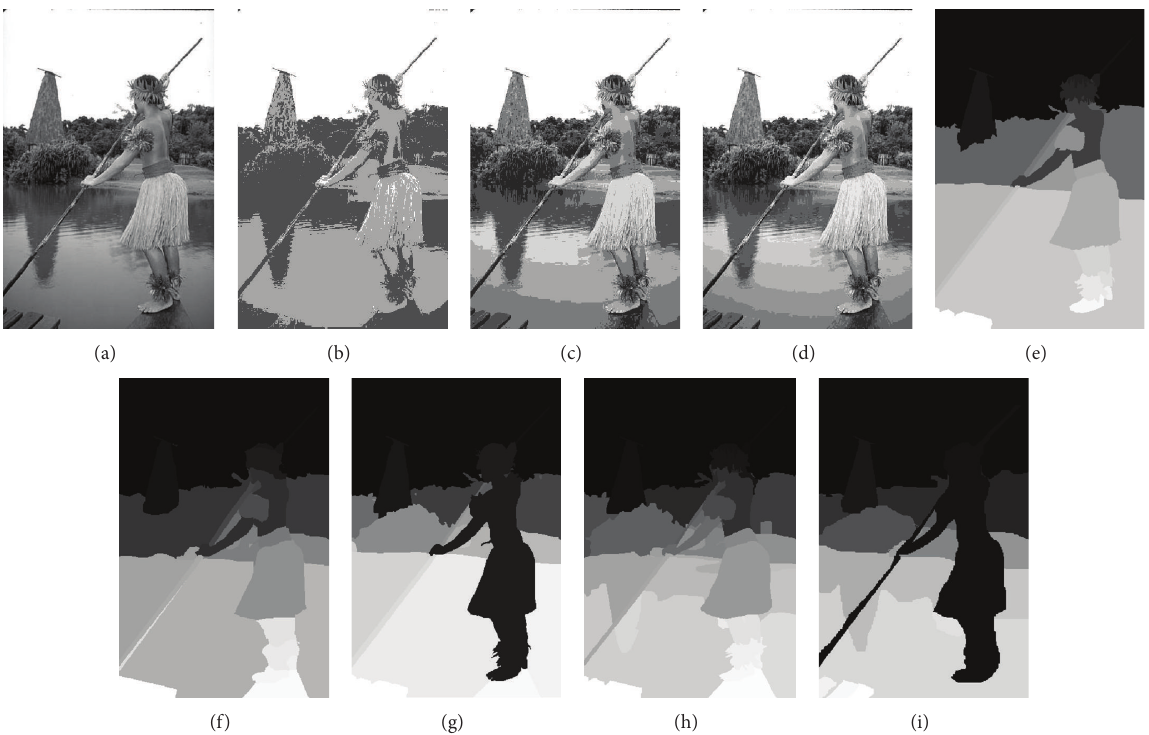
Figure 13: (a) Original image 101087, (b) M − 1 = 2 PRI = 0.76849 , (c) M − 1 = 5 PRI = 0.85694 , (d) M − 1 = 9 PRI = 0.88633 , (e)–(i) the ground-truth hand segmentations offered by Berkeley Segmentation